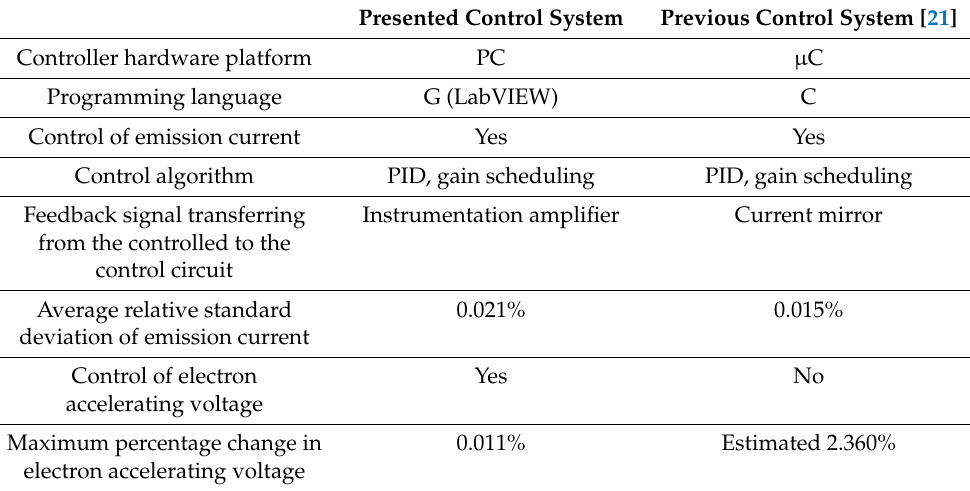
Table 1. Control systems